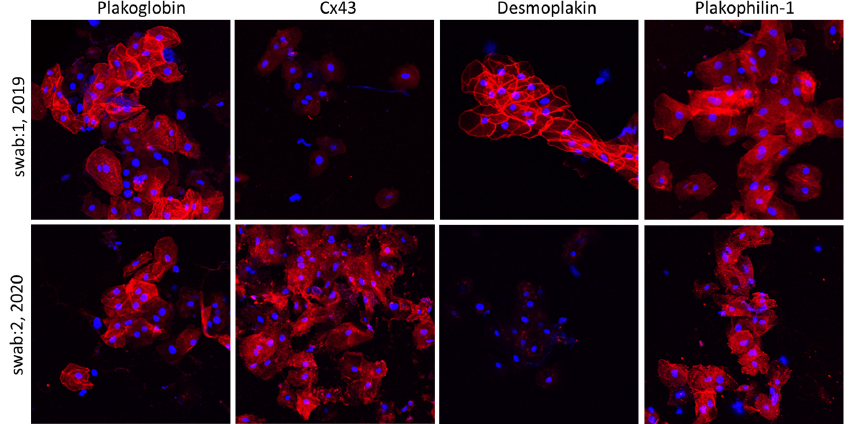
Figure 3. Confocal immunofluorescence images of two sets of buccal smears obtained from a child with a diagnosis of ACM bearing a DSP mutation. The first set of samples shows control localization for DSP, PG and PKP1, but membrane signal for Cx43 is virtually absent. In the second set of samples, obtained 18 months later, the immunoreactive signal for DSP appears to be missing from the membranes, while the distribution of Cx43 is now corrected to control-looking levels. Restoration of Cx43 signal correlated with a favorable response to beta blockers’ initiation